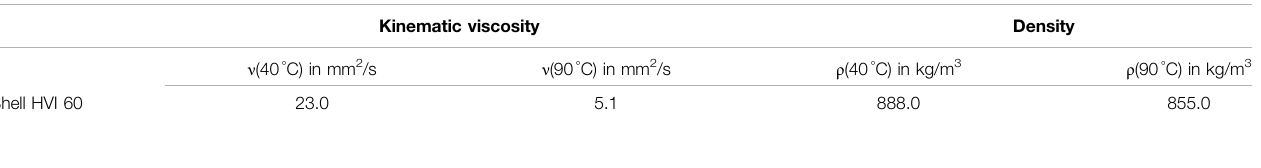
TABLE 5 | Main lubricant properties of Shell HVI 60 (van der Kruk et al.,